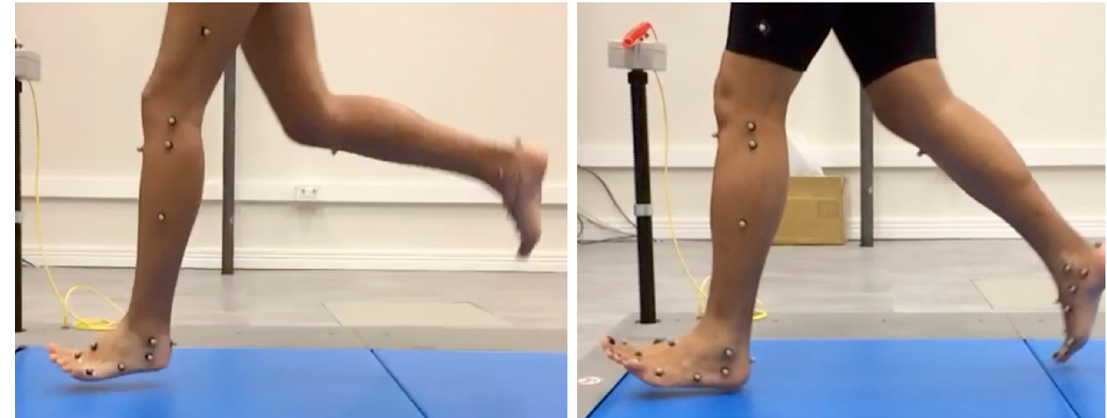
Figure 2. Illustrations showing the experimental protocol, taken while subjects were running on the force-sensing tandem treadmill at their self-selected speed. Runner’s typical footstrike pattern, either forefoot (FFS, left picture) or rearfoot strike (RFS, right picture) pattern, was verified against kinematic data and slow-motion sagittal-plane videos from high-speed cameras. Appl. Sci. 2020 , 10 , x FOR PEER REVIEW